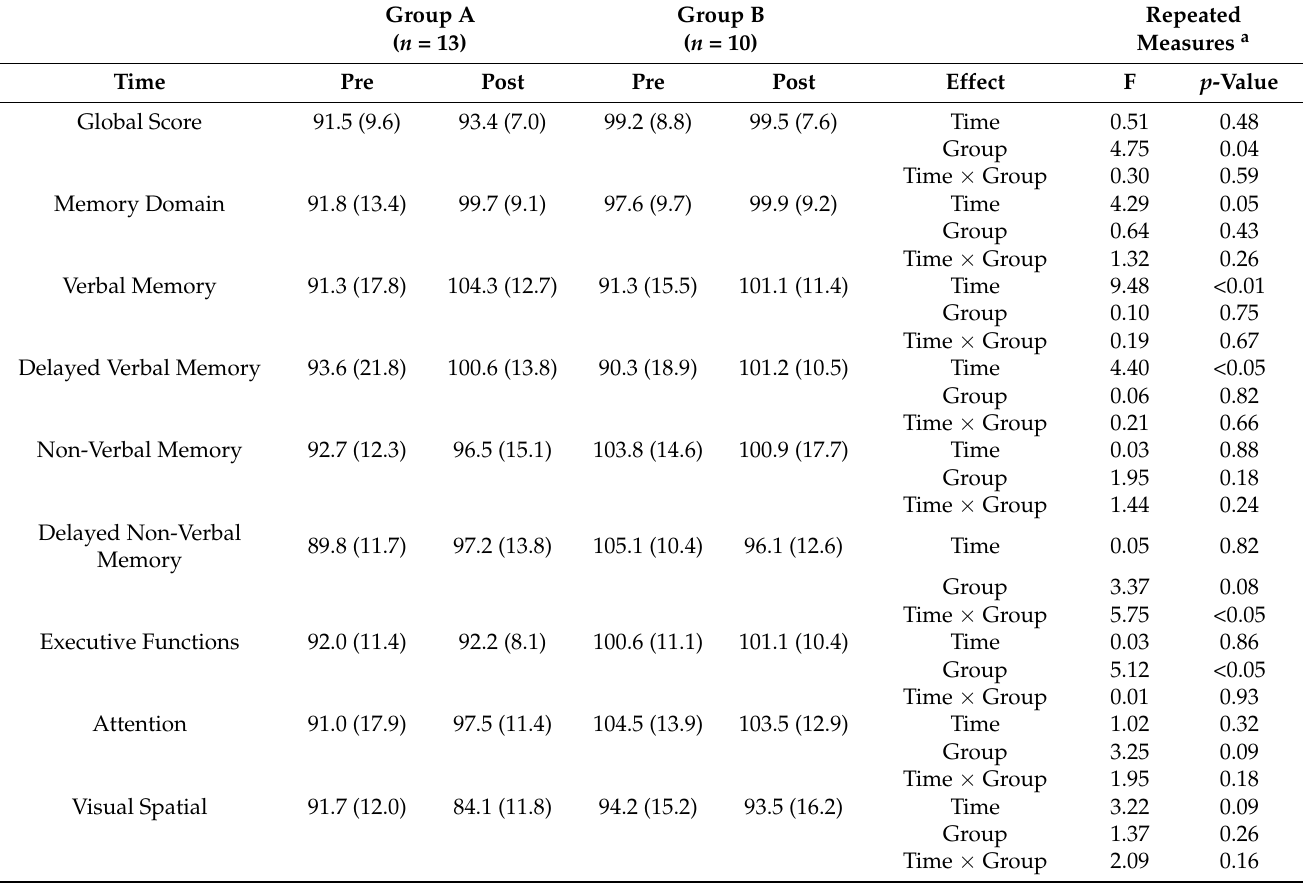
Table 3. Results for the NeuroTrax cognitive domains and memory sub-components pre-intervention and post-intervention according to groups.